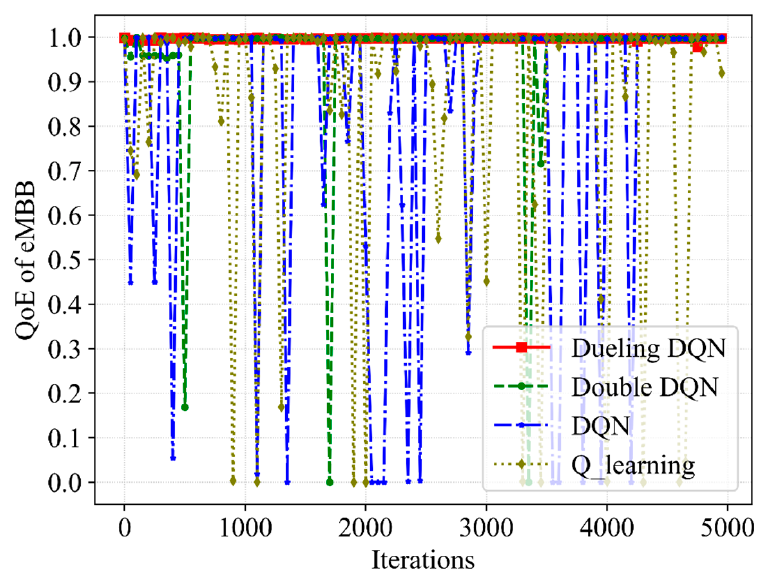
Figure 3. A comparative result of QoE for eMBB service with different slicing algorithms.